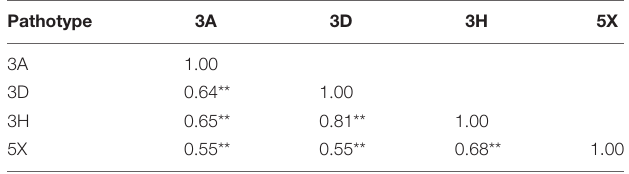
TABLE 2 | Correlation coefficients for clubroot severity after inoculation of DH population derived from BC 2 of DH16516 × ECD01 for resistance to four pathotypes of P. brassicae